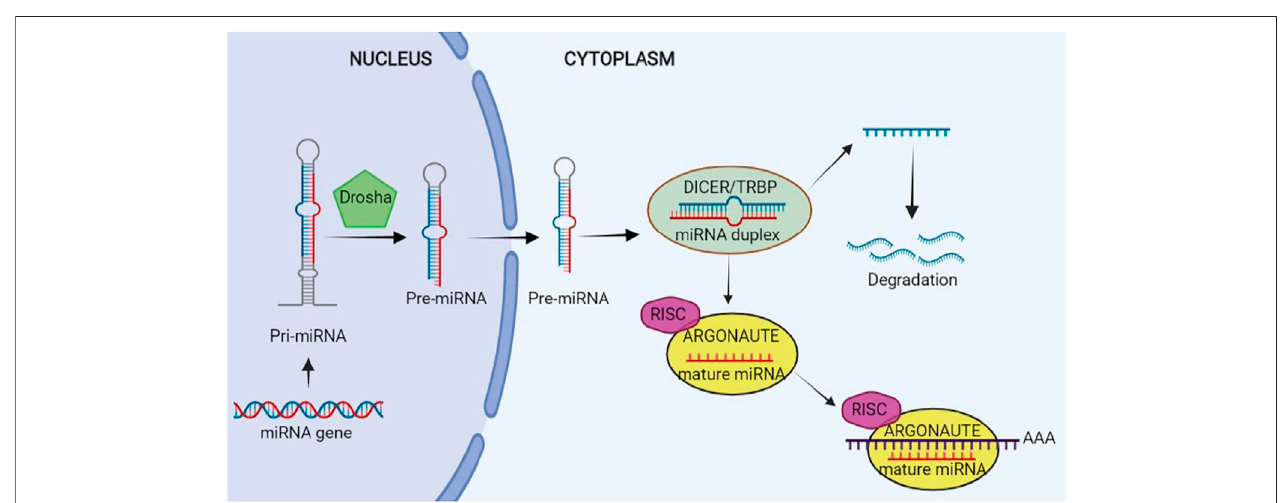
FIGURE 2 | Biogenesis of microRNA (miRNA). This fi gure is created by www.BioRender.com.